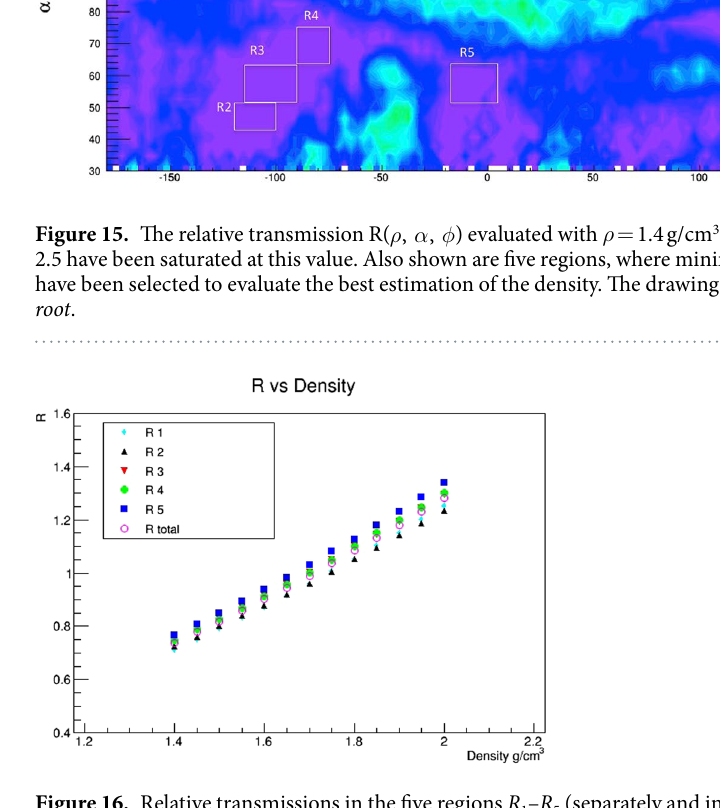
Figure 16. Relative transmissions in the five regions R 1 – R 5 (separately and in total) as functions of ρ . The drawing was obtained using the software root .